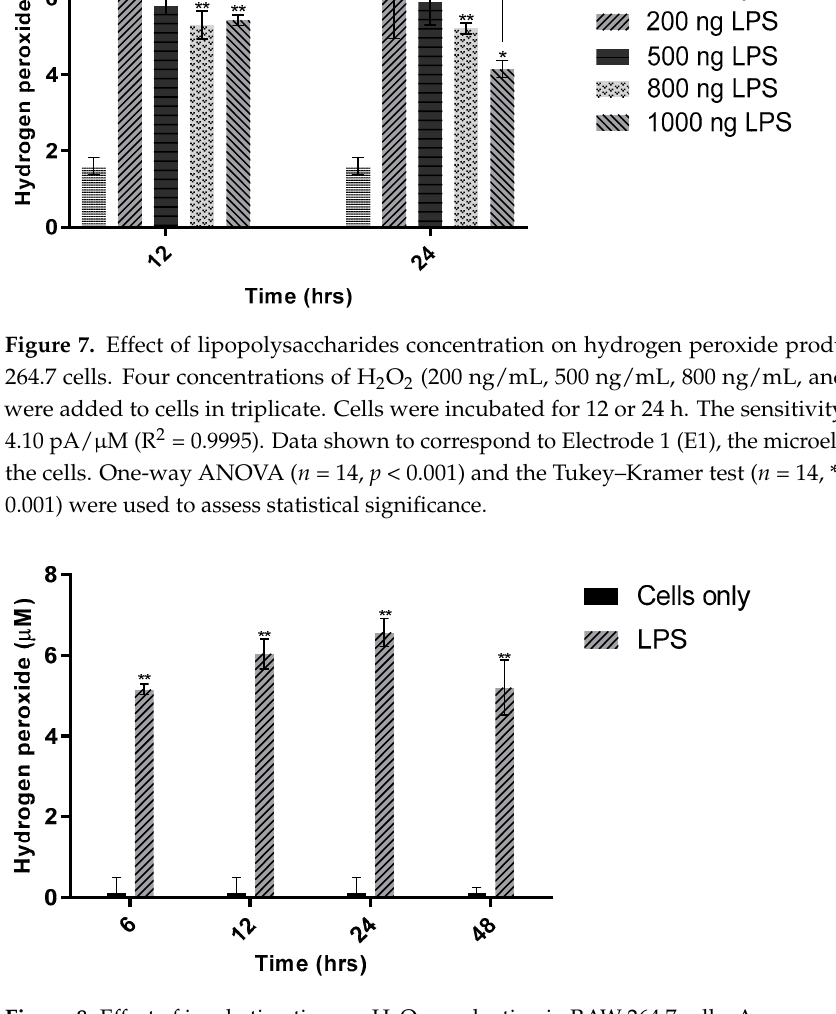
Figure 8. Effect of incubation time on H 2 O 2 production in RAW 264.7 cells. An amount of 200 ng/mL LPS was added to cells plated in triplicate in 24-well plates (seeding density: 1 × 10 5 cells/mL). Cells were incubated for 6, 12, 24, or 48 h. Probe sensitivity: 11.0 pA/ µ M (R 2 = 0.9997). One-way ANOVA ( n = 21, p < 0.001) and the Tukey–Kramer test ( n = 21, ** p < 0.001) were used to assess statistical significance.